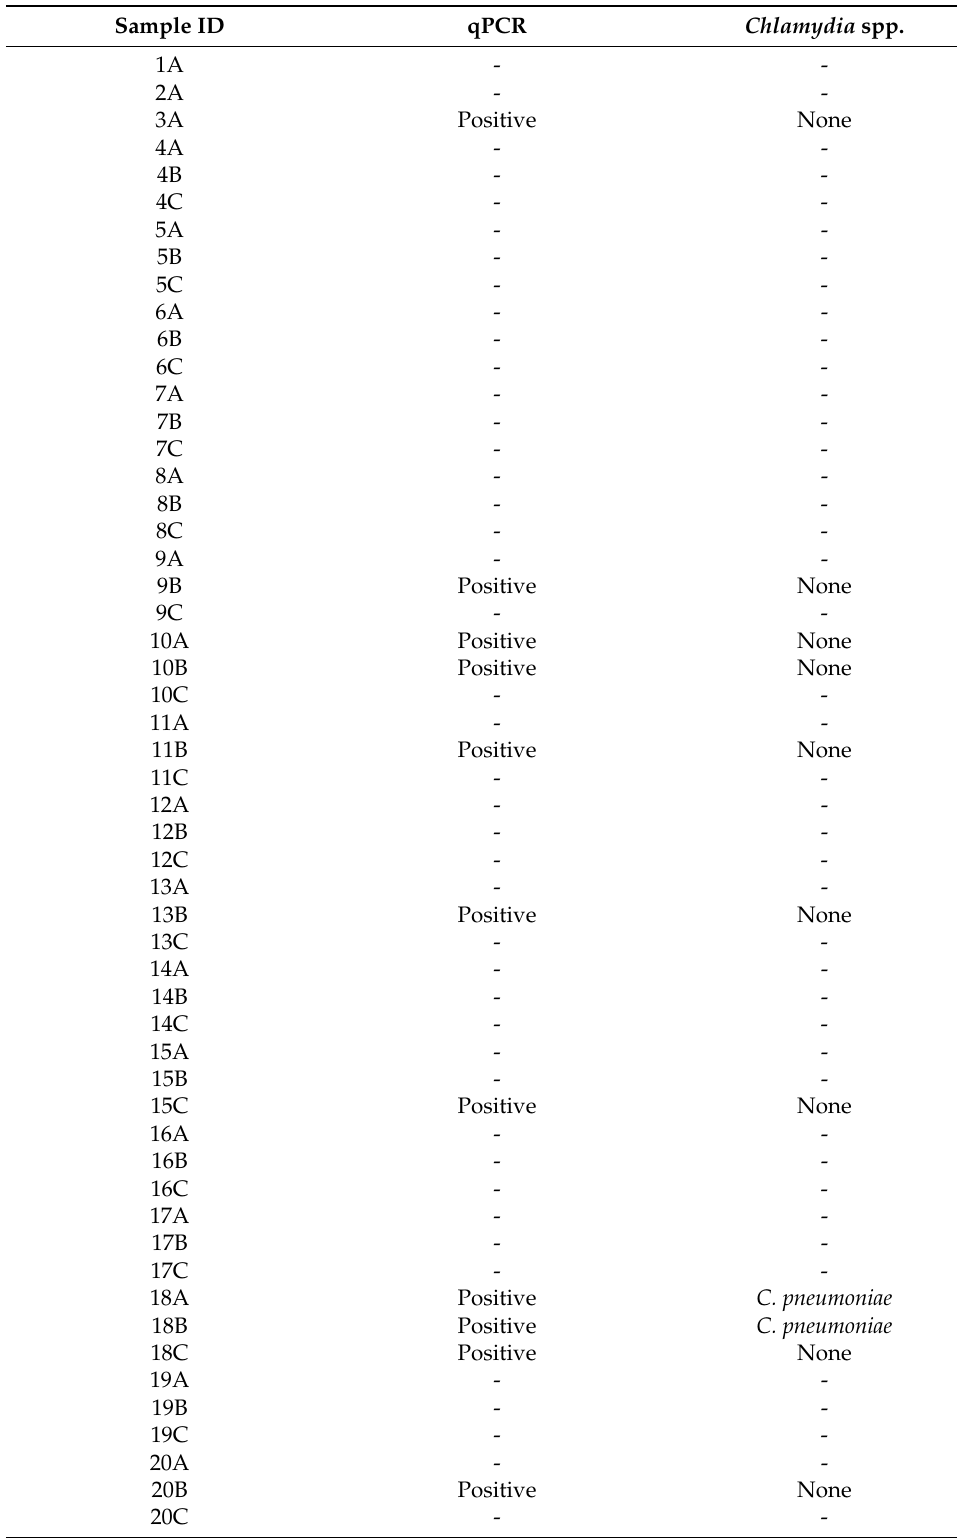
Table 3. Detection of Chlamydial DNA from oropharyngeal, ocular-conjunctival and nasal swabs of 20 loggerhead sea turtles (performed at IZSLER). Results of the quantitative PCR (qPCR) targeting the Chlamydiaceae 23S gene. Positive samples were further analysed through quantitative PCR to identify potential zoonotic species (i.e., C. pecorum , C. pneumoniae , and C. psittaci